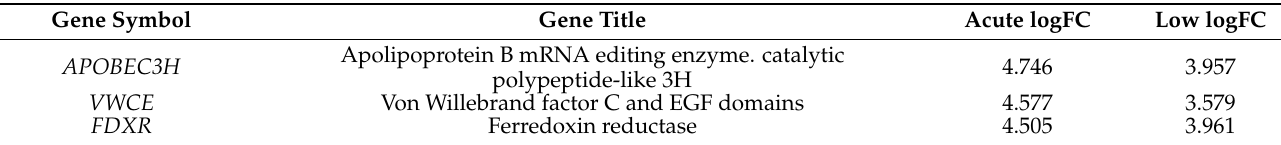
Table A2. List of genes for the dose of 4.45 Gy that are common in both lists of the two administration regimes for this dose, acute or low